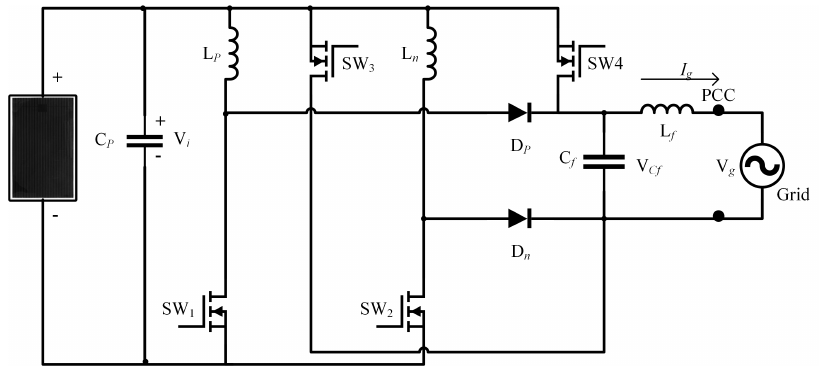
Figure 1. Buck-Boost Single-stage